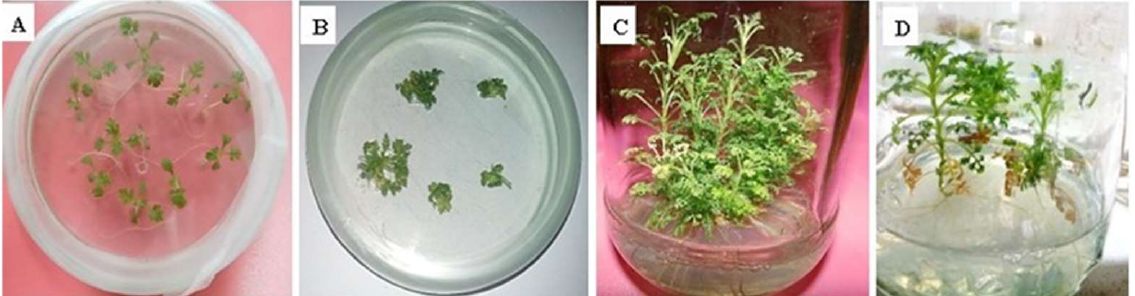
Figure 1. Genetic transformation of Artemisia carvifolia . ( A ) Seeds germination, ( B ) co-cultivation, ( C ) wild type plant, ( D ) rol A transgenic plant.